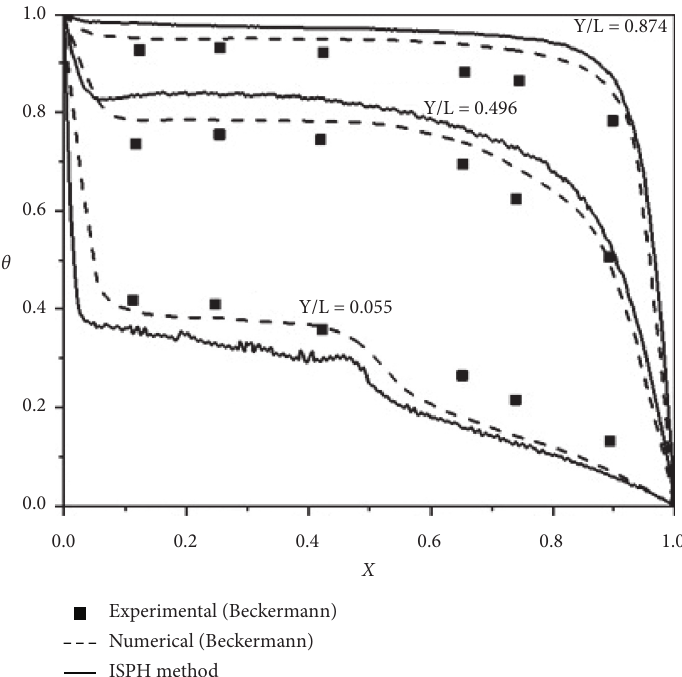
Figure 2: Comparison of the temperature profiles in a partitioned porous cavity between Beckermann et al. [48] and ISPH method. 0.80.0 0.2